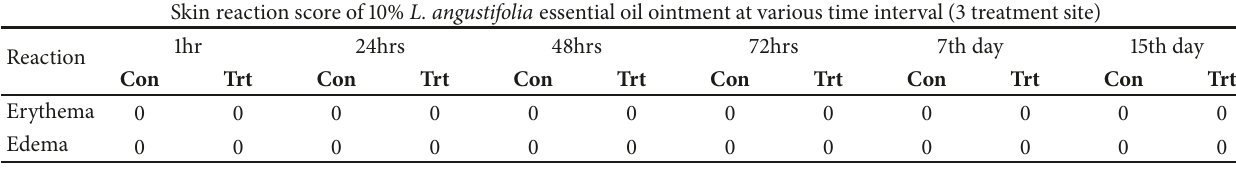
Table 3: Score of edema and erythema after removing the test formulation.